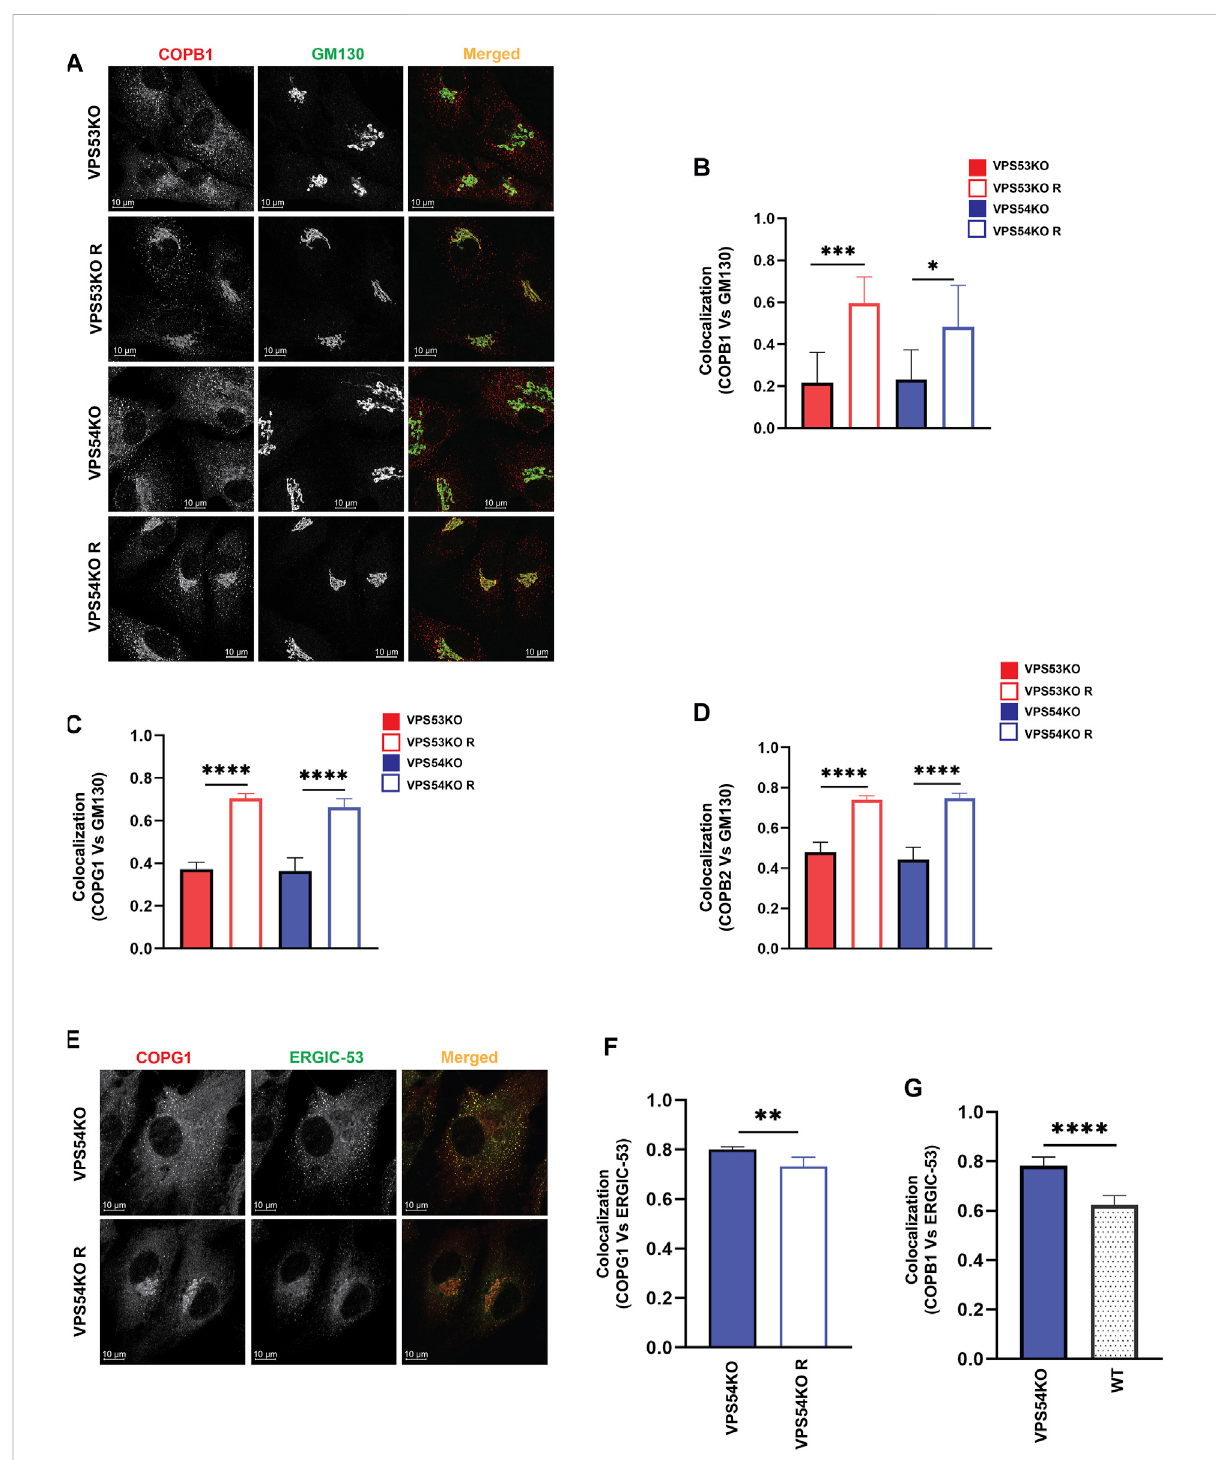
FIGURE 6 COPIsubunitsaredisplacedfromtheGolgiinGARP-KOcells. (A) AiryscanmicroscopyofGARP-KOcellsandcontrolcellsstainedwithantibody to coatomer subunit COPB1. Colocalization analysis of COPB1 and GM130 (B) , COPG1 and GM130 (C) , COPB2 and GM130 (D) using Pearson ’ s correlation coef fi cient. n = 40 cells used for colocalization analysis per group. (E) Airyscan microscopy of COPG1 and ERGIC-53 in VPS54KO and VPS54KORcells. (F) Colocalization analysis ofCOPG1and ERGIC-53 and (G) COPB1 andERGIC-53 using Pearson ’ scorrelationcoef fi cient. n = 40 cells used for colocalization analysis. Statistical signi fi cance was calculated using one-way ANOVA. **** p ≤ 0.0001, ** p ≤ 0.01.